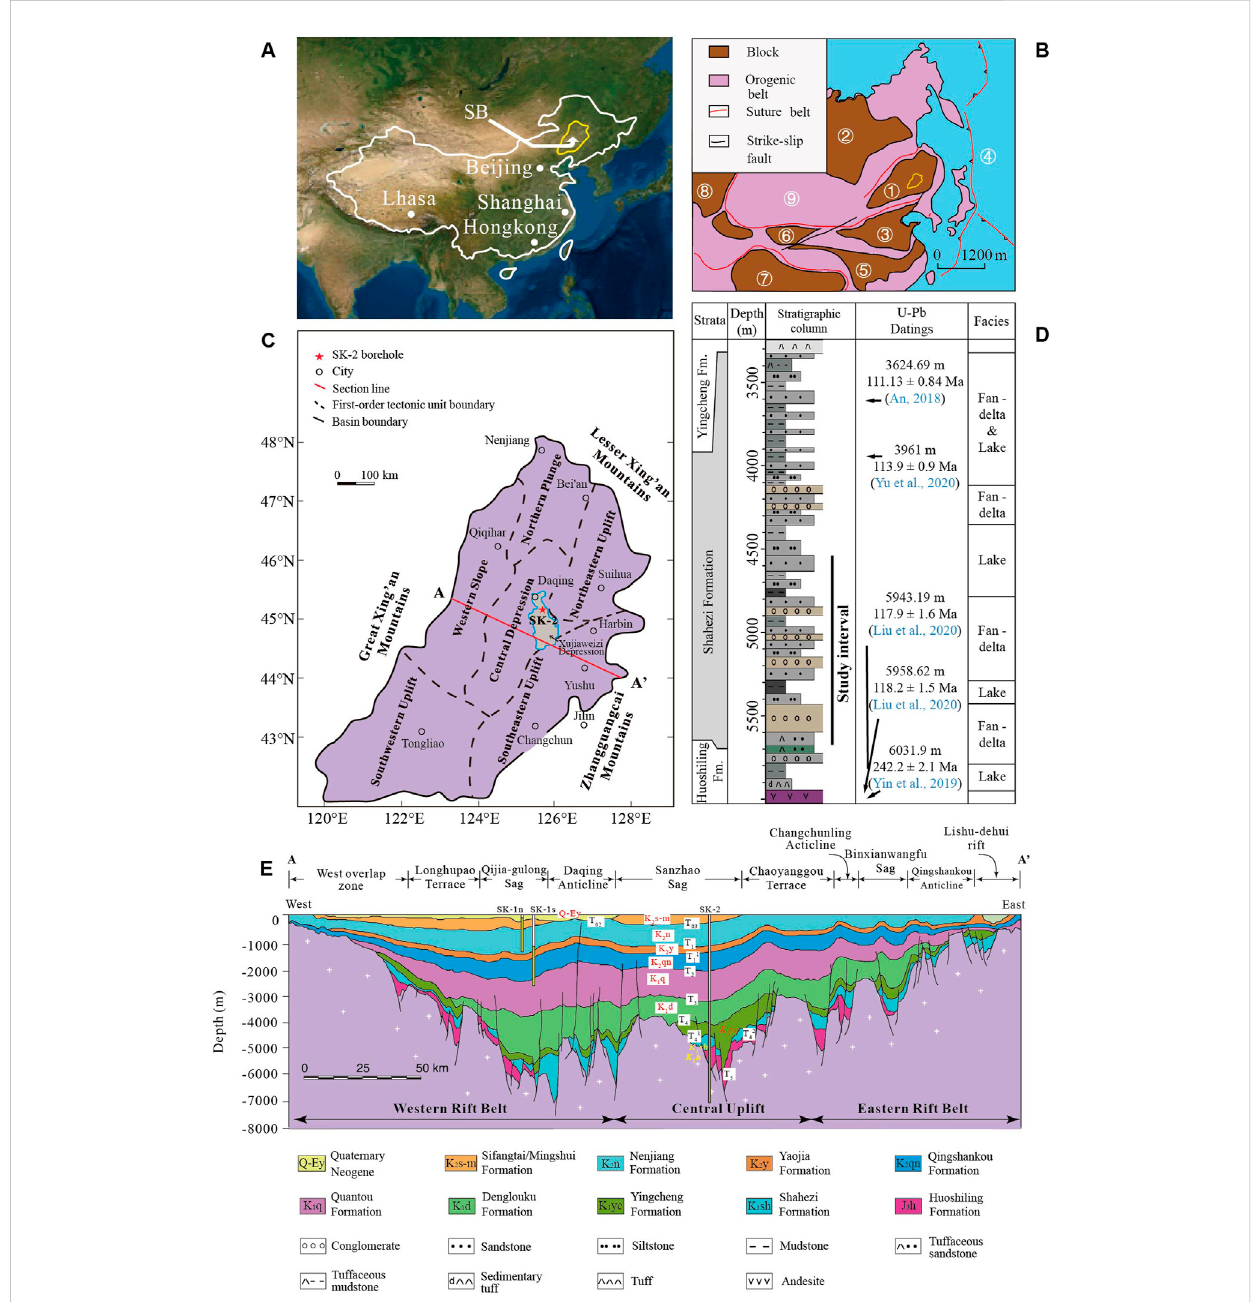
FIGURE 1 (A) LocationoftheSongliaoBasin(SB)innortheasternChinesemainland (B) TectonicsofEastAsia,yellowcircleisthesameas (A) , ① Jiamengblock, ② Siberianblock, ③ NorthChinablock, ④ Paci fi cplate, ⑤ SouthChinablock, ⑥ Tarimblock, ⑦ Indiablock, ⑧ EasternEuropeblock, and ⑨ CentralAsian orogenic belt(modi fi edfromZhouetal.,2009) (C) The fi rst-ordertectonic unitsofSBandlocationofSK-2borehole(modi fi edfromFengetal.,2013) (D) Stratigraphic sequence of the Shahezi Formation in SK-2 and corresponding age data (modi fi ed from Liu et al., 2020), the black line represents interval in this study (E) The structural section across the central SB (A-A ′ in (C) ) and sites of the boreholes which had been drilled in Continental Deep Scienti fi c Drilling of SB up to 2018. The yellow bars are intervals with continuous coring, and white bars are uncored intervals (modi fi ed from Wang et al.,